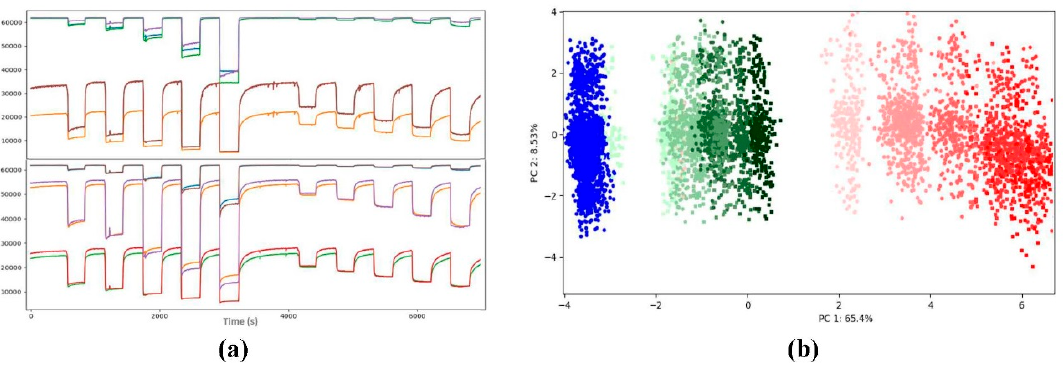
Figure 3. ( a ) Raw data for increasing concentrations of ethanol and acetone ( b ) PCA scores plot for the discrimination of compounds and